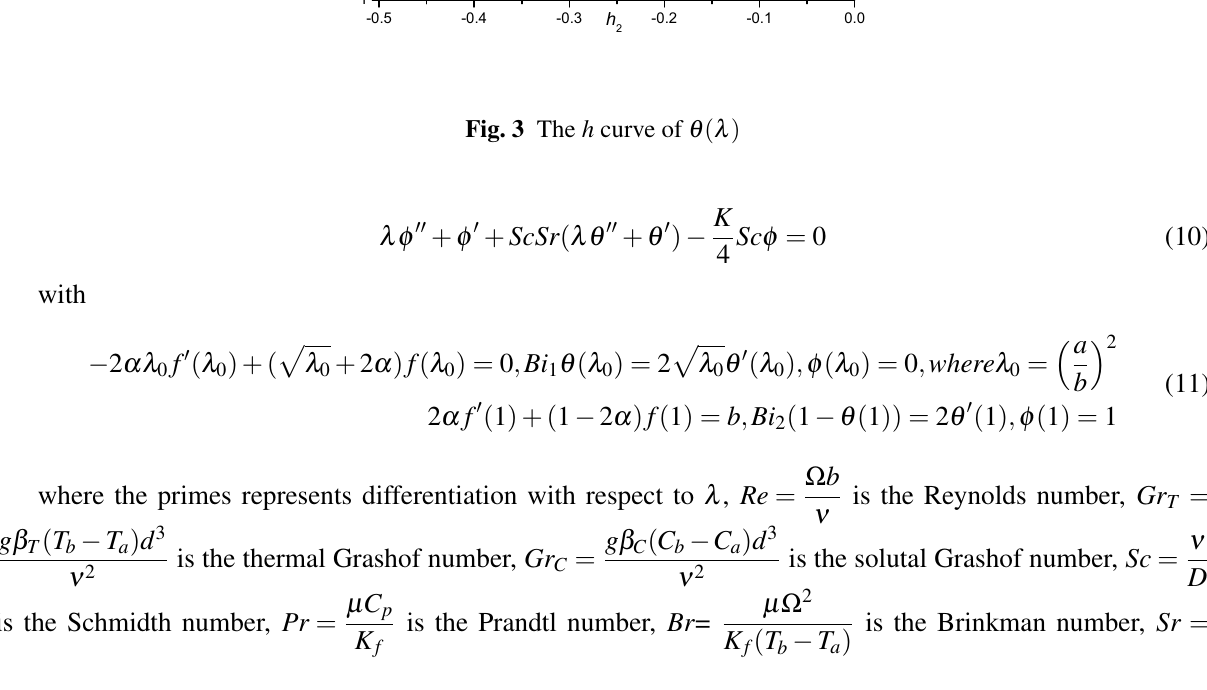
Fig. 3 The h curve of θ ( λ